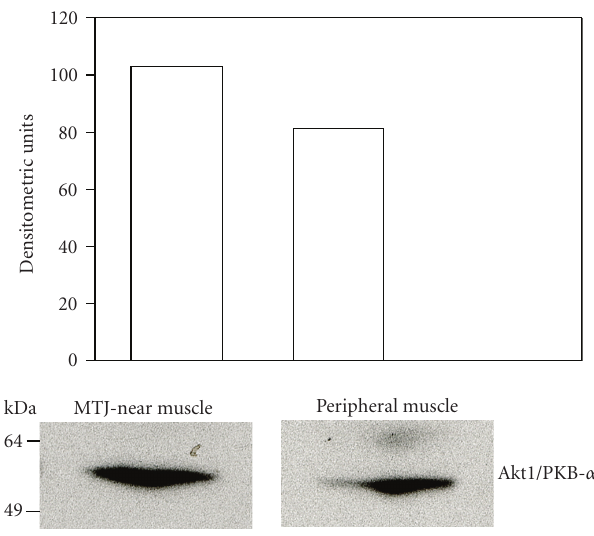
Figure 4: Immunoblot analysis of p-Akt1/PKB α Ser473 in periph- eral muscle fibers and in muscle fibers near to the myotendinous areas. Protein extracts prepared from peripheral masticatory muscle fibers and masticatory muscle fibers at MTJ were analyzed by immunoblotting using an antibody against Akt1/PKB α phospho- rylated at Ser473. The weakly phosphorylation of Akt1/PKB α at Ser473 in peripheral muscle fibers is significantly increased in muscle fibers near to the MTJ. A characteristic band almost at 60kDa for p-Akt1/PKB α Ser473 was detectable with a higher staining intensity in muscle fibers near to the